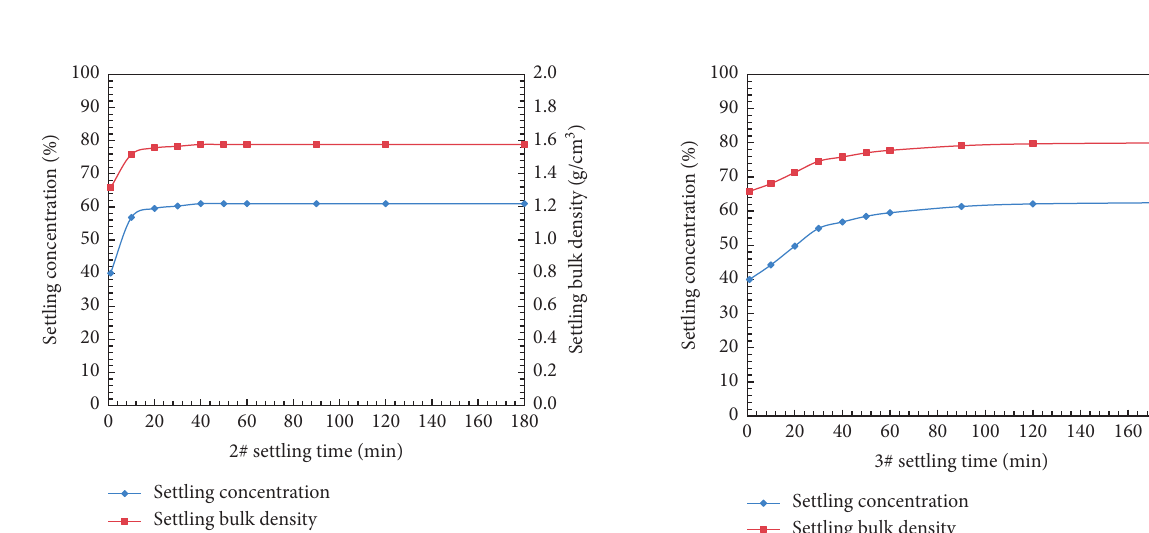
Figure 5: Flocculating sedimentation test parameters of tailings (#2).